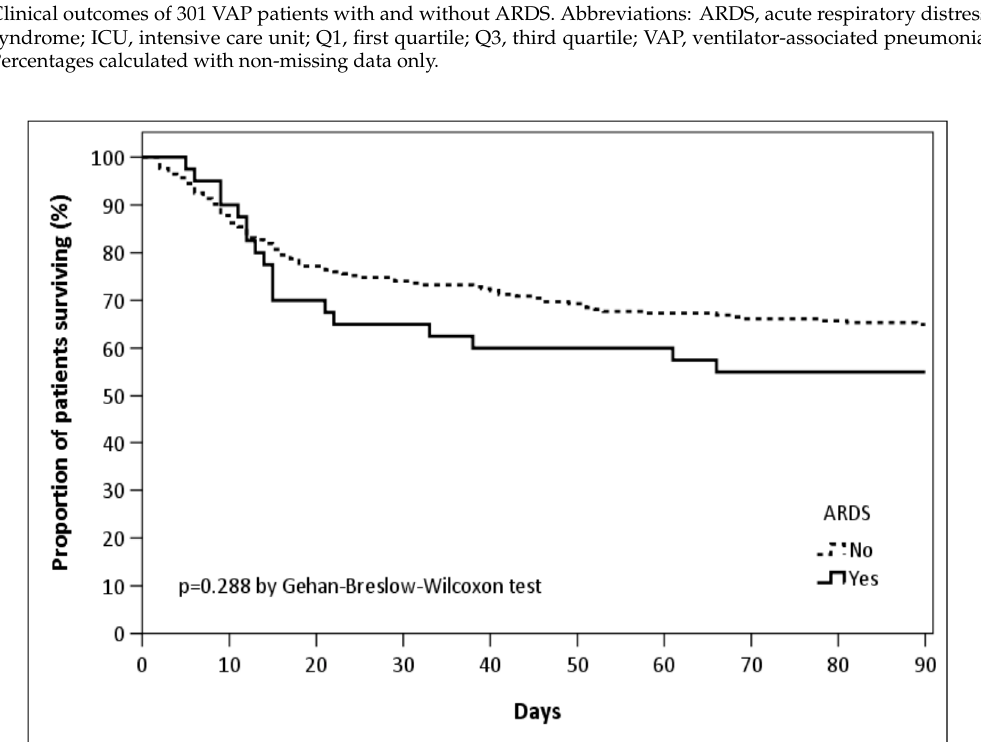
Table 3. Clinical outcomes.